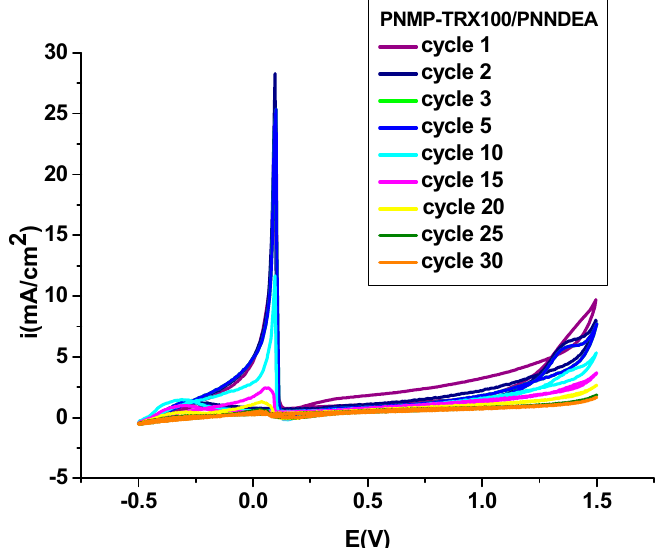
Figure 3. Cyclic voltammograms of OL 37 electrode coated with PNMPY-TRX-100/PNNDEA/OL 37 in 0.3 M H 2 C 2 O 4 at a potential range − 0.5 and 1.5 V vs. SCE and scan rate of 20 mV/s.